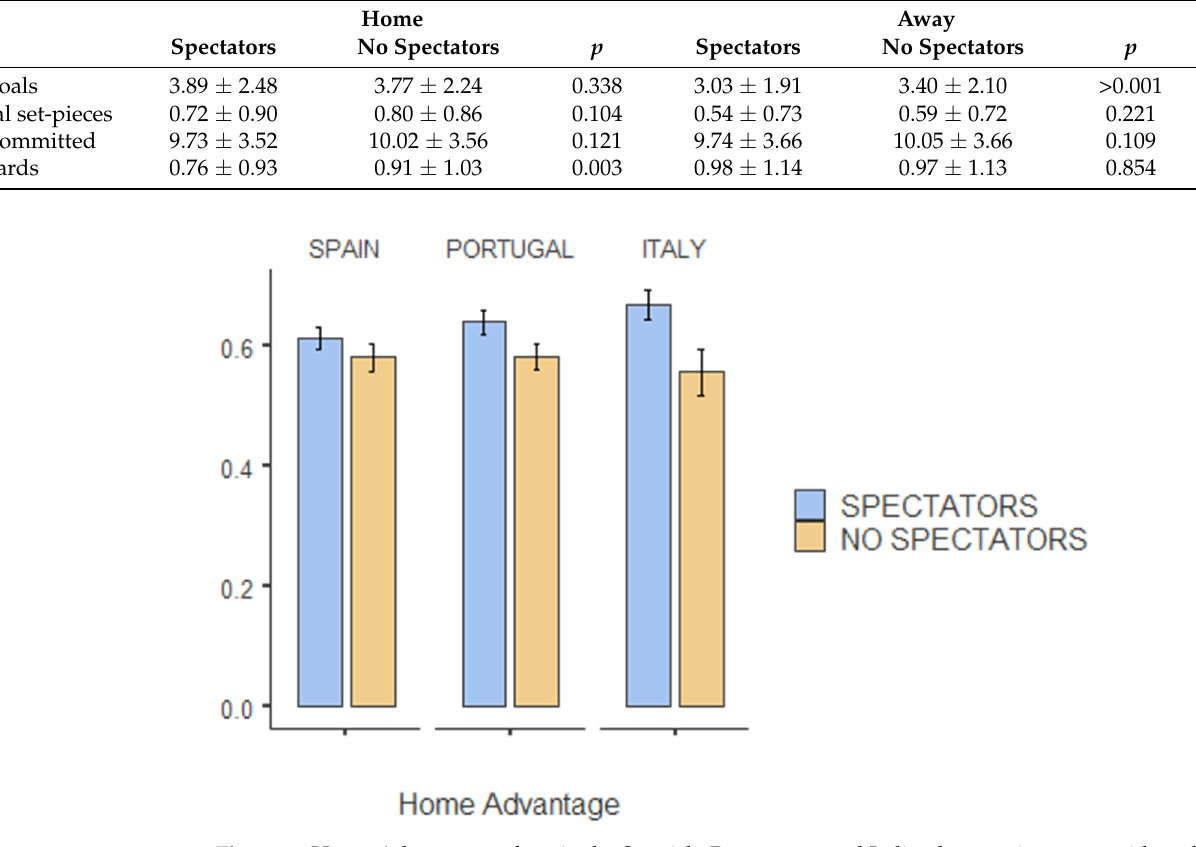
Figure 2. Home Advantage values in the Spanish, Portuguese and Italian leagues in games with and without spectators.